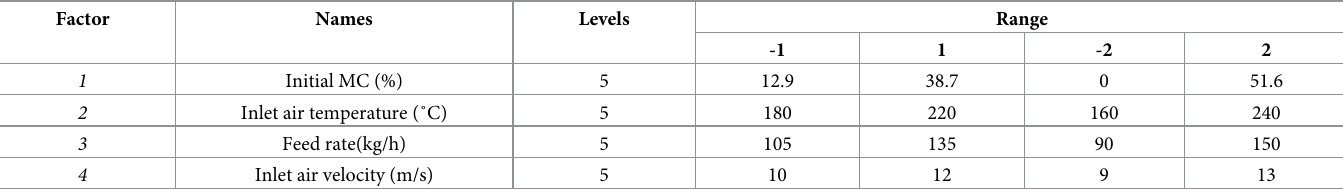
Table 1. Experimental ranges and levels of independent variables used in multiple linear regressions. Factor